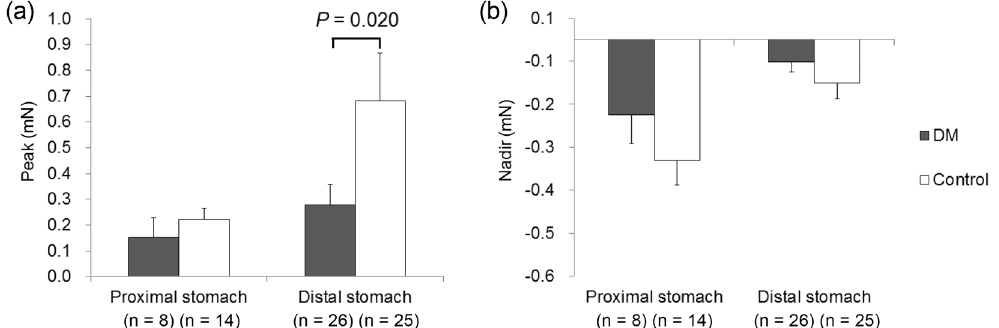
Figure 4. Electrical field stimulation (EFS)-induced response of gastric longitudinal muscle strips in the control state. ( a ) The peak did not differ between diabetic patients and control subjects in the proximal stomach but was greater in control subjects than in diabetic patients in the distal stomach. ( b ) The nadir did not differ between diabetic patients and control subjects in both the proximal and distal